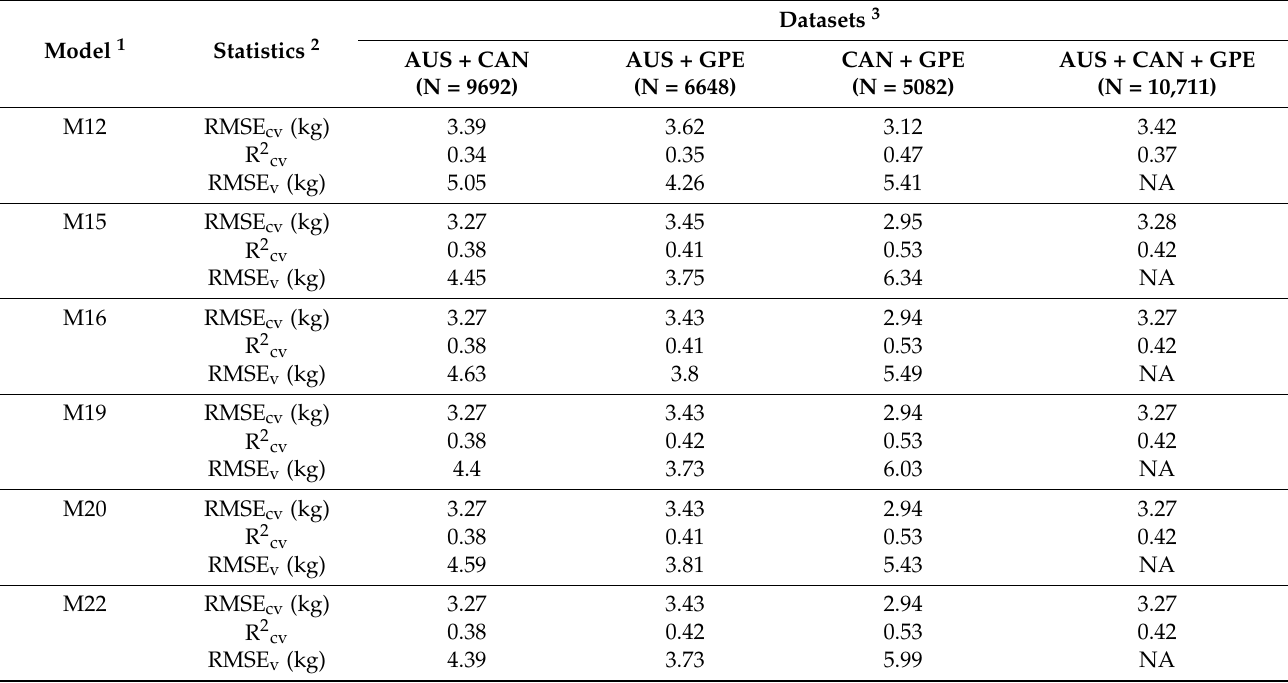
Table 3. Cow-independent cross-validation and out-of-sample country-independent performance for partial least squares regressions predicting the dry matter intake (in kg) of dairy cows from a dataset coming data coming from 3 different origins (AUS = Australia, CAN = Canada, GPE = GplusE project).